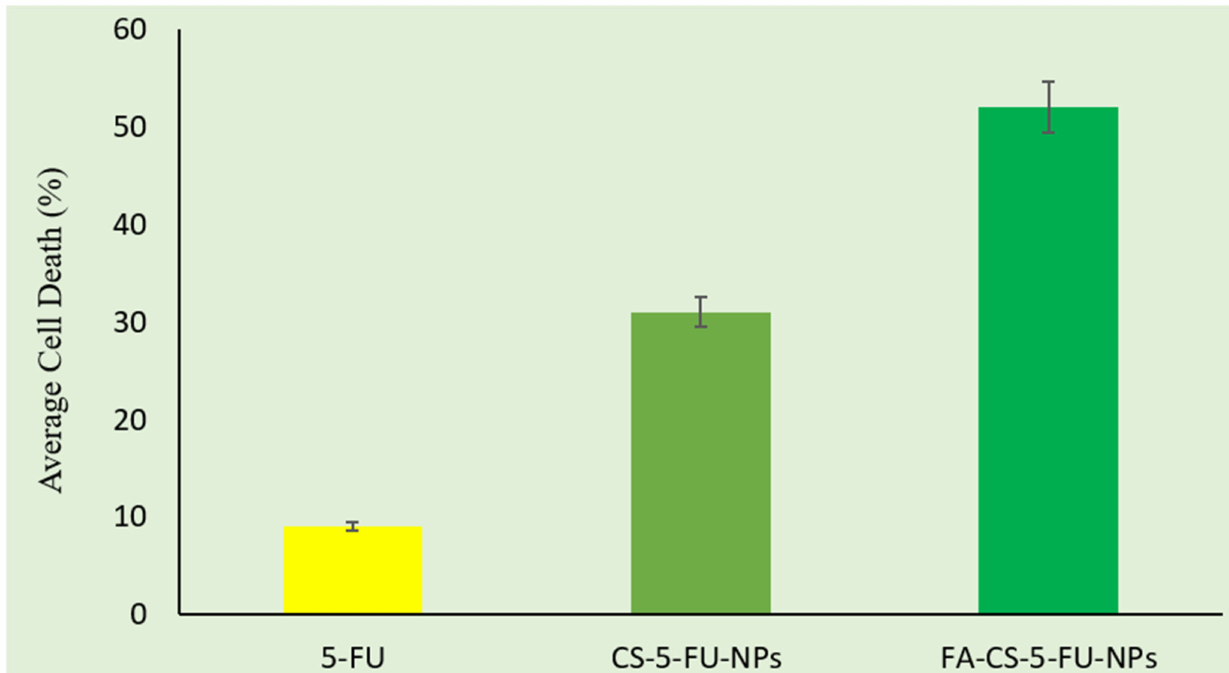
Figure 6. Cytotoxicity study shows the % cell death of 5-FU, CS-5-FU-NPs, and